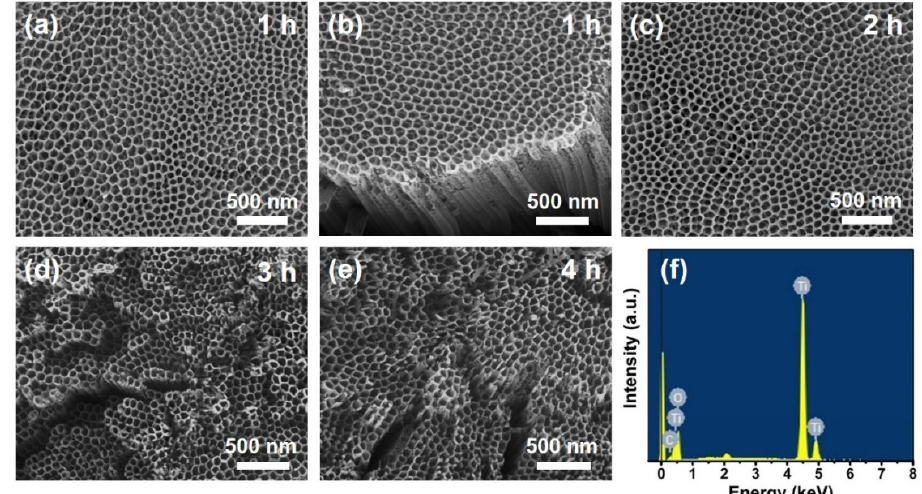
Figure 1. ( a – e ) Top-view of FE-SEM images of the annealed anodic TiO 2 nanotube (NT) electrodes